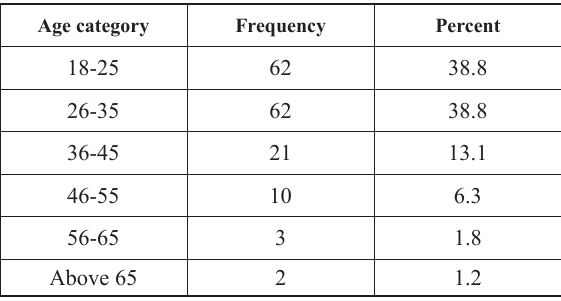
Table 1. Gender data of participants Gender Table 2. Age category data of participants Age category